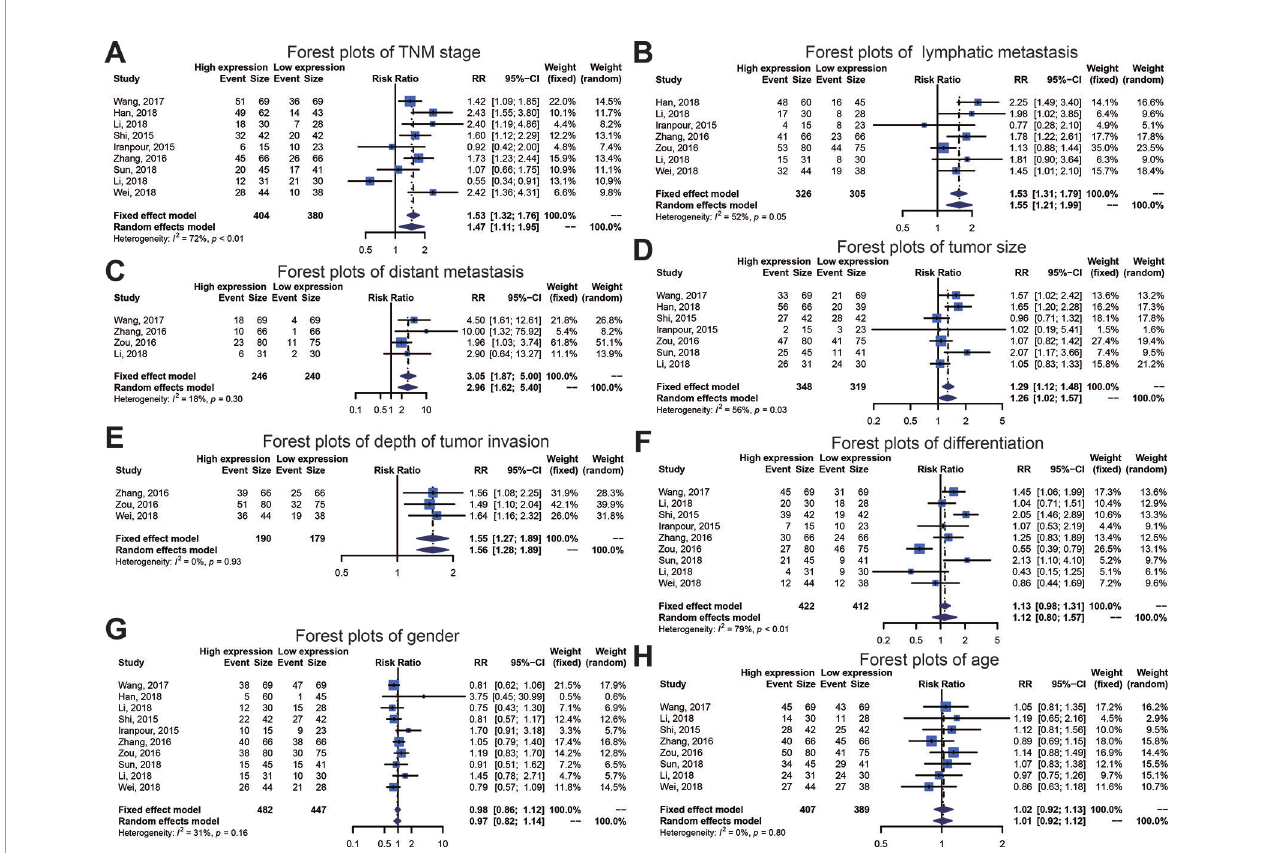
FIGURE 3 | Forest plots of main clinical parameters under the upregulation or downregulation of SOX2 overlapping transcript (SOX2-OT). (A) tumor, node, metastasis (TNM) stage, (B) lymphatic metastasis, (C) distant metastasis, (D) tumor size, (E) depth of tumor invasion, (F) differentiation, (G) gender, and (H)